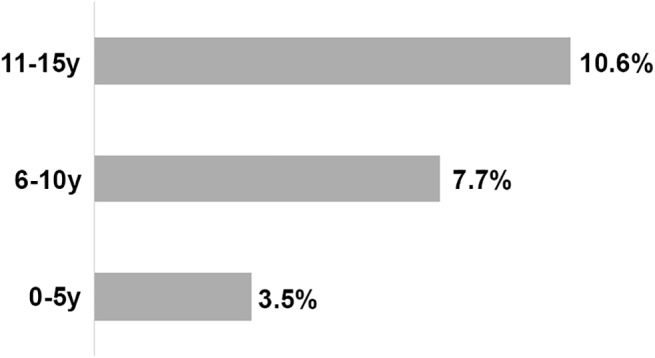
Prevalence of M. perstans according to age for all positive children.(y = year-old).